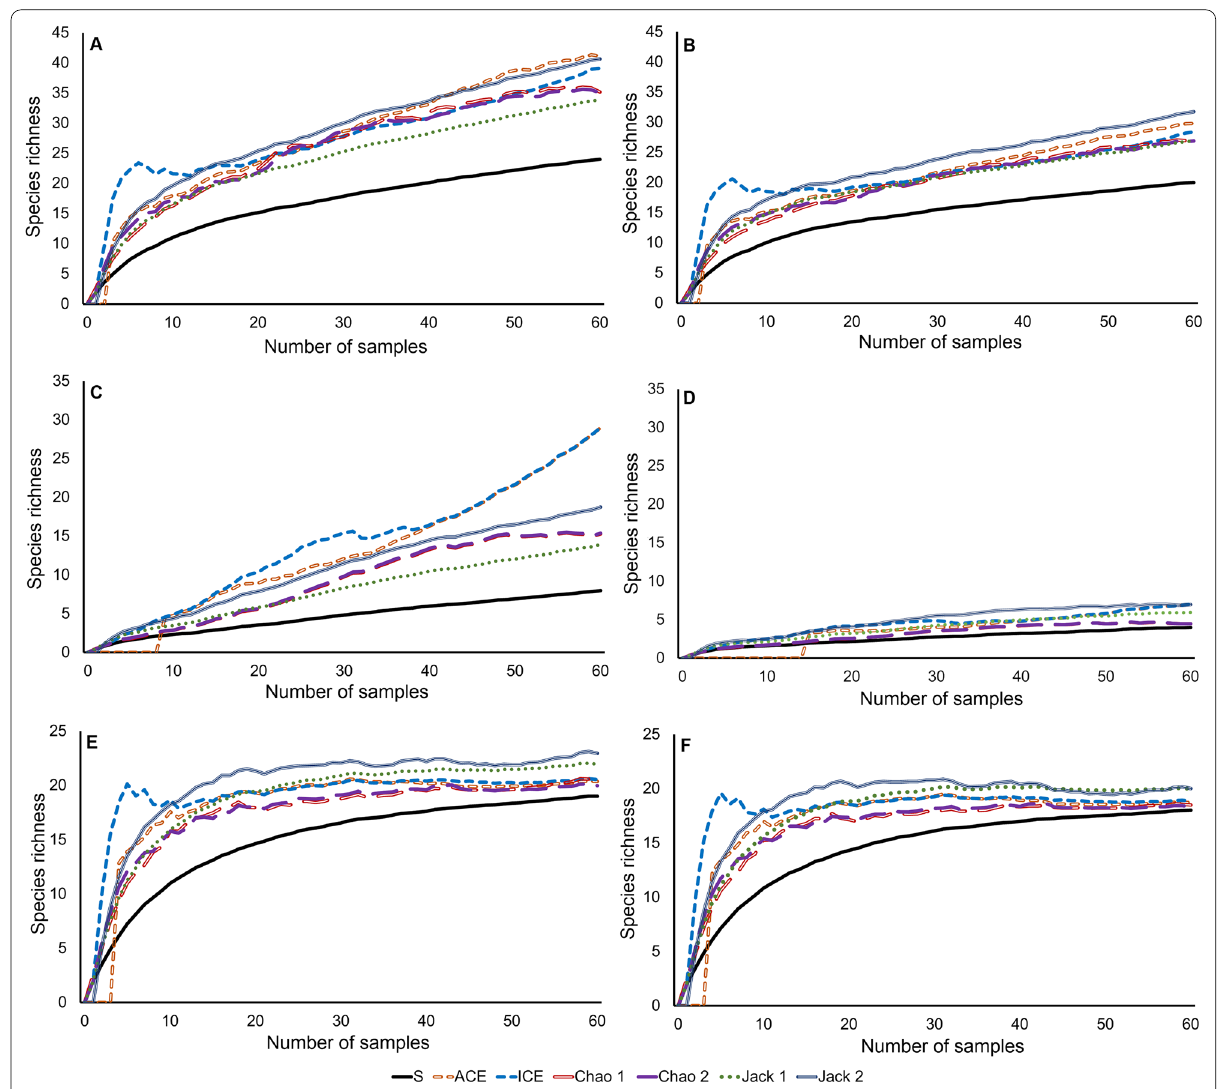
Fig. 8 Species richness estimation curves for Pampa del Indio Provincial Park, Chaco, Argentina, with adult litter, E , F : grassland; A – C – E : analyses with HTS; B – D – F : analyses without